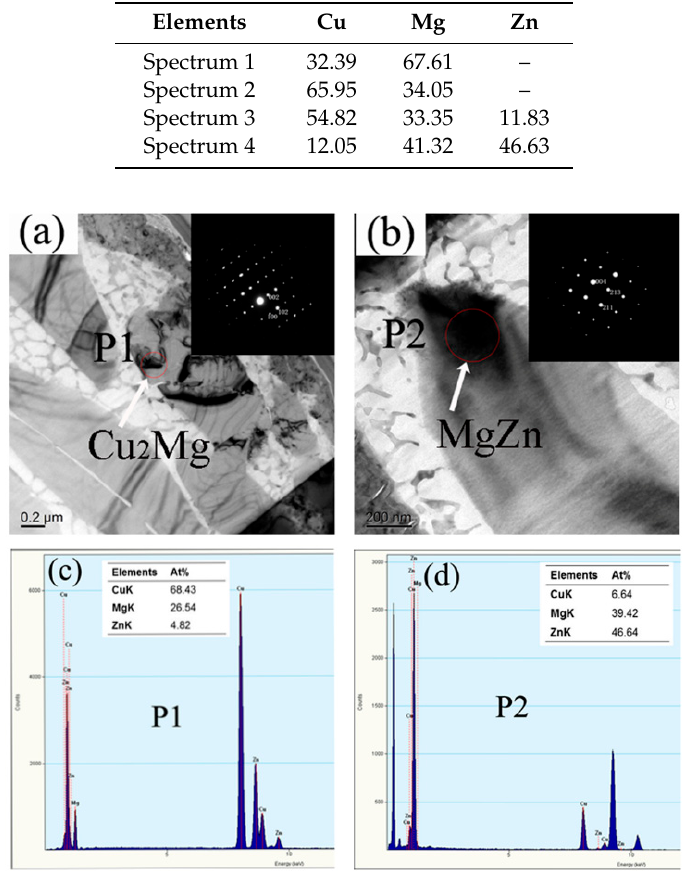
Table 3. EDX results of the reaction layers described in Figure 4 (at%).